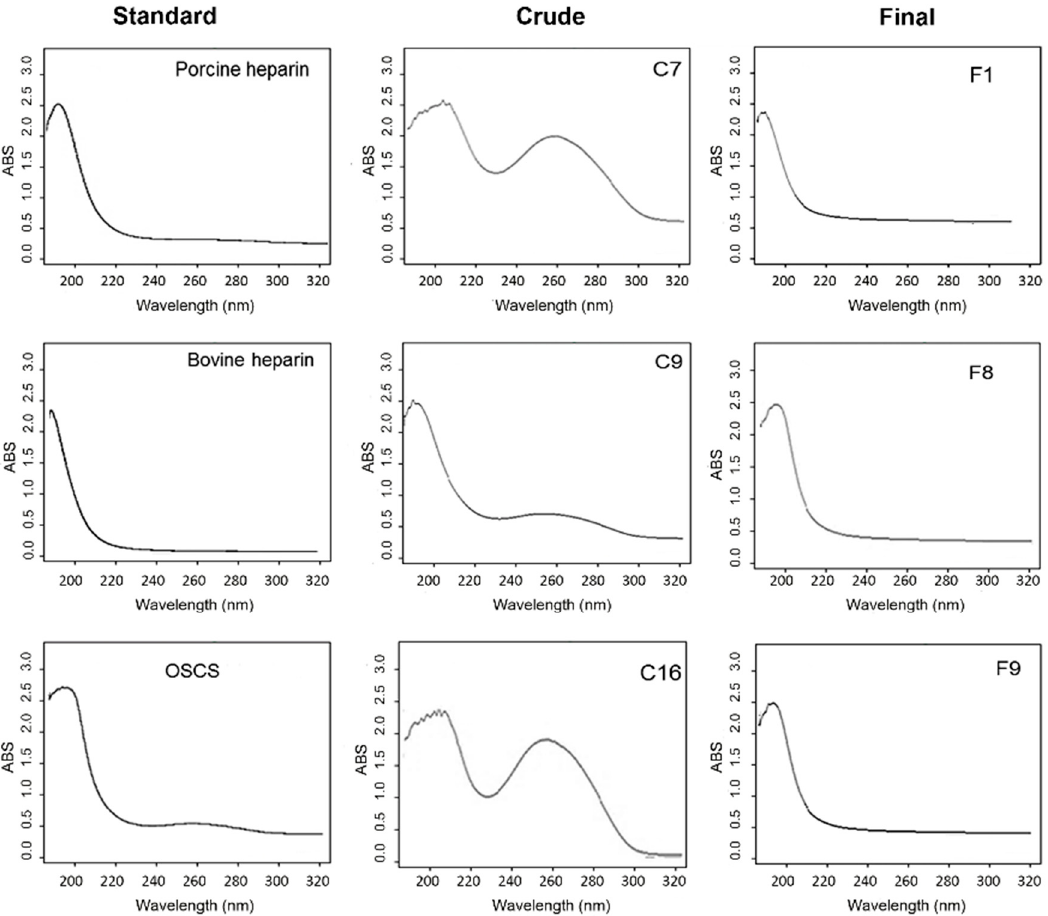
Figure 2. Analysis of crude and final heparins by UV scanning spectroscopy (190–320 nm). UV spectra were performed on UV / VIS spectrophotometer using 1 mg / mL solution in water in the range of 190–320 nm, with a reading rate of 120 nm / min with a resolution of 1 nm at room temperature. Standard heparin UV spectra shows a narrow peak of 190–210 nm whereas, on the other hand, contaminated heparins have a broader peak around 200–220 nm, as well as an additional broad signal around 240–260 nm (nucleic acids, peptides). C7, C9 and C16: crude heparin samples; F1, F8 and F9: final heparin